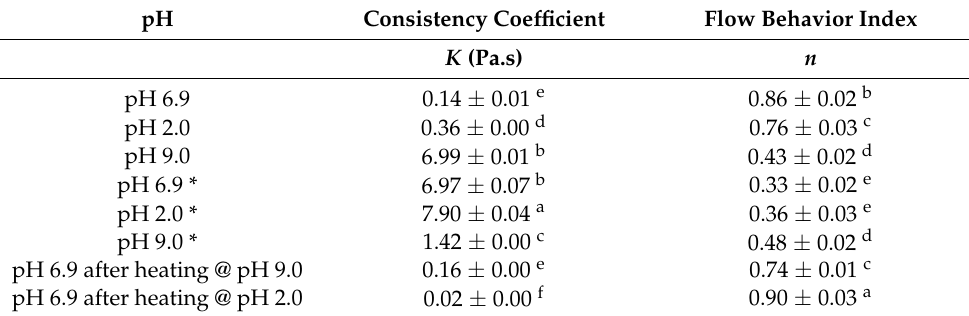
Table 2. Rheological parameters, consistency coefficient, and flow behavior index of soy protein isolate dispersions (10%, w/w , protein) as a function of pH before and after heat